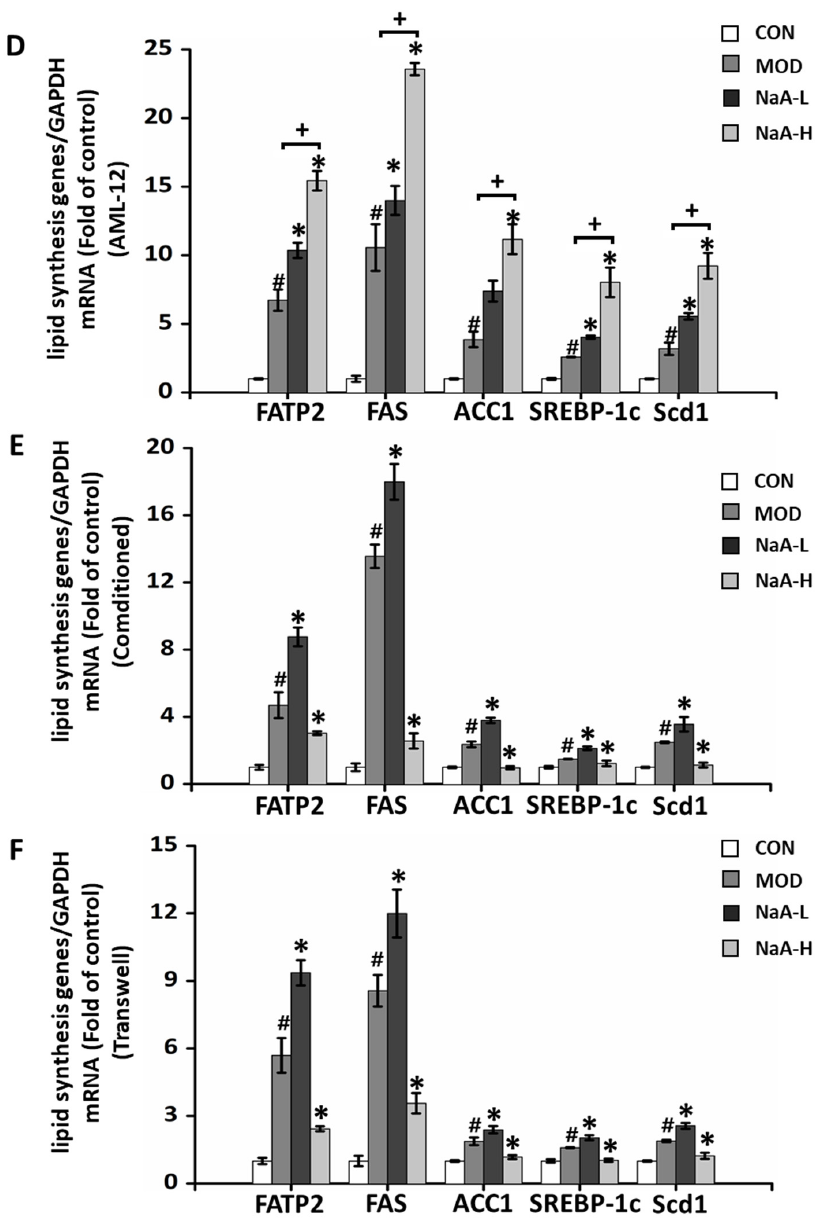
Figure 7. NaA affects the lipid accumulation of hepatocytes by regulating macrophage activity. ( A ) Oil Red O staining was used to detect the lipid deposition (magnification: 100 × , scale bar: 500 μ m). The bar graph displays percentages of lipid accumulation ( n = 6–10). ( B ) The levels of hepatic tri ‐ glycerides. ( C ) The levels of hepatic cholesterol. ( D – F ) qRT ‐ PCR was used to evaluate the mRNA expressions of lipid synthesis genes ( Scd1, FAS, ACC1, SREBP, FASn ). For all bar graphs, data are the mean ± SD, # p < 0.05, as compared with CON, * p < 0.05, as compared with MOD, + p < 0.05. The significant difference was assessed using the one ‐ way ANOVA followed by LSD post ‐ tests. Control group (CON), group model cell treated with an LPS (MOD), 0.1 mM sodium acetate group (NaA ‐ L), 2 mM sodium acetate group (NaA ‐ H), arbitrary unit (AU).